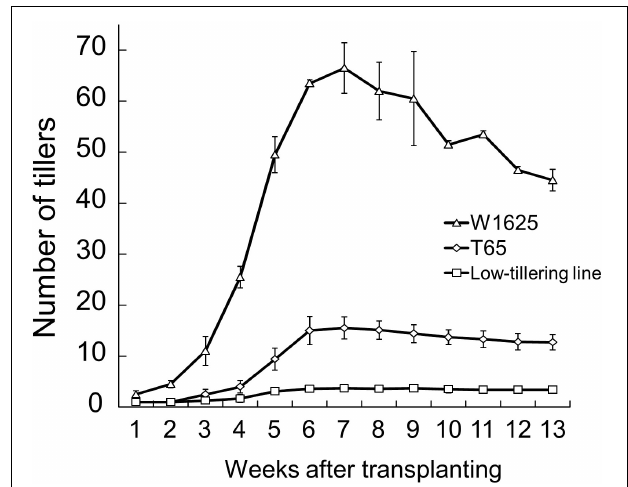
FIGURE 2 | Fluctuation in tiller number during plant development in W1625, T65, and the low-tillering line. Data are means ± SD ( n = 10).